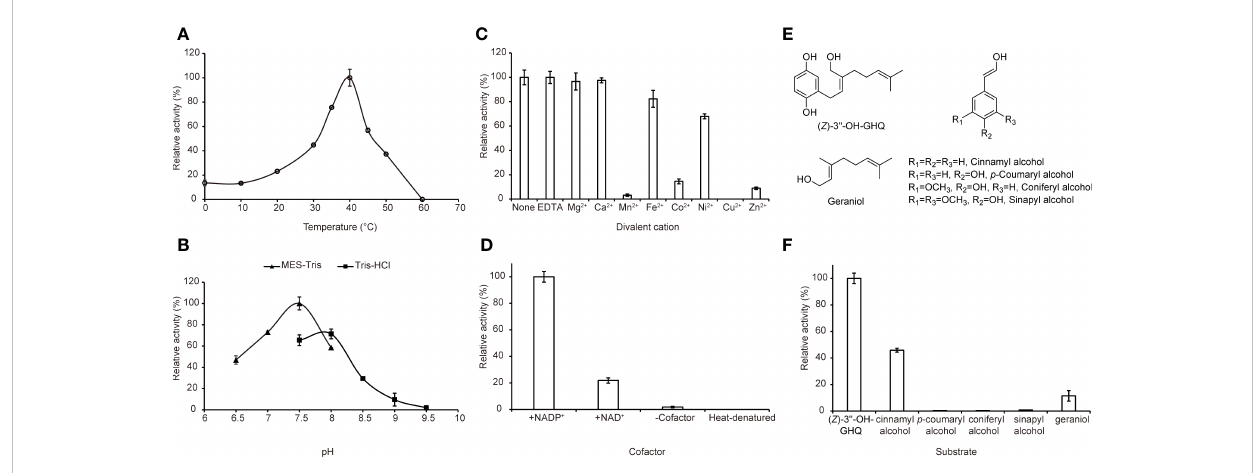
FIGURE 5 Biochemical properties of AeHGO. For the quantitative measurements of the enzyme activity, three parallel assays are carried out. The error bar represents the standard deviation of a measurement. For each quantitative measurement, relative activity is shown with the sample having the highest activity set arbitrarily at 100%. (A) Effects of temperature on the enzyme activities of AeHGO. (B) pH dependences of AeHGO. (C) Effects of various divalent metal ions on AeHGO activities. (D) Cofactor dependences of AeHGO. (E) Chemical structures of used substrates in speci fi city analysis. (F) Comparison of substrate speci fi cities of puri fi ed